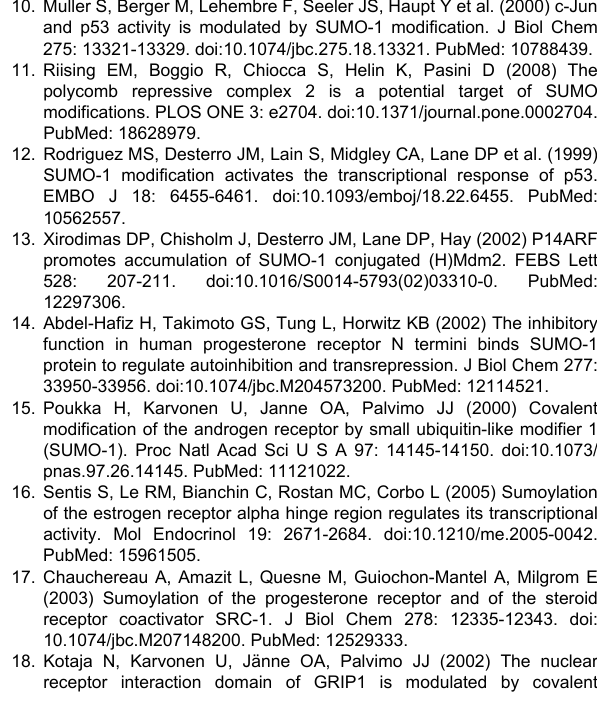
Table S1. List of oligonucleotide sequences used in this